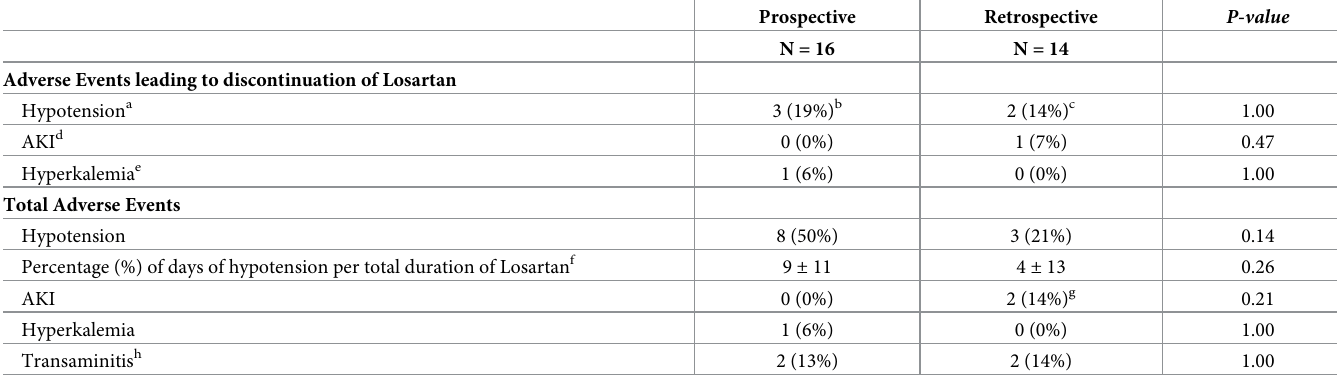
losartan was discontinued in the third patient due to holding parameters of SBP < 120 mmHg by the primary team. Similarly, discontinuation of losartan due to persistent hypotension only occurred in 2 (14%) patients in the retrospective cohort (Table 3). Table 3. Adverse events in the study